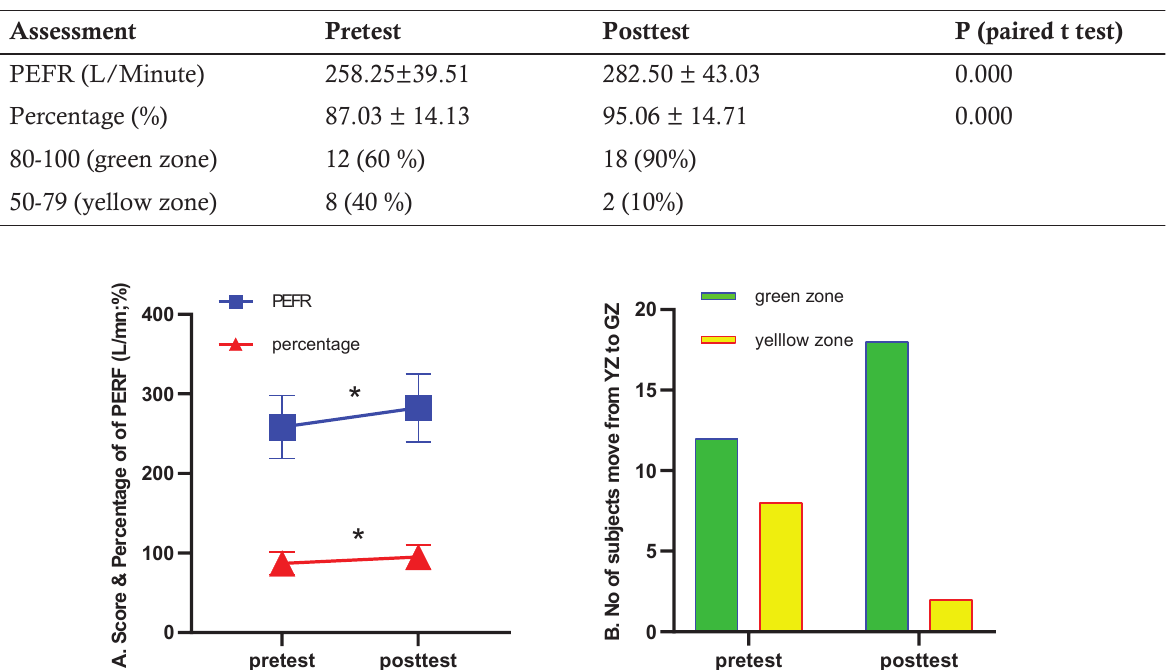
Table 2. Result of Pretest and Posttest PEFR Assessment